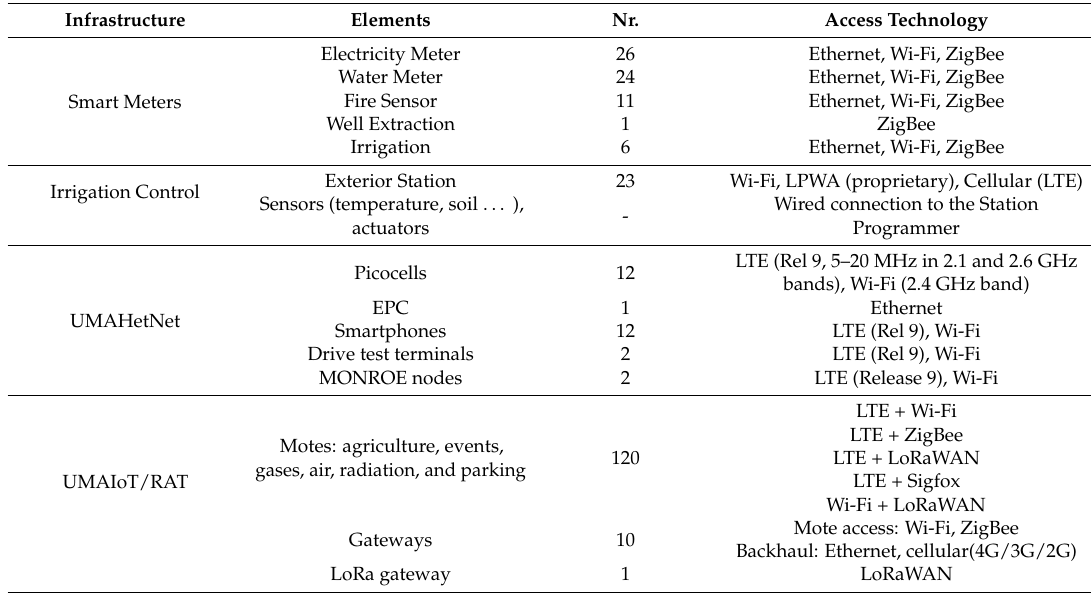
Table 2. Internet of Things (IoT) main elements and communication